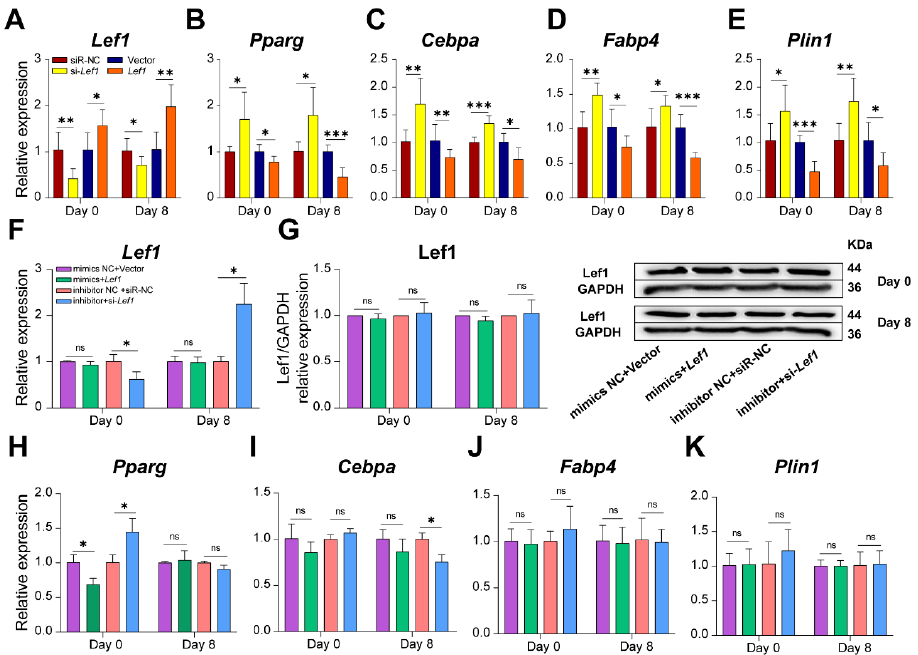
Figure 8. miR-34a abolished the suppressive function of overexpressed Lef1 on fat deposition during 3T3-L1 differentiation. The expression of Lef1 ( A ), Pparg ( B ), Cebpa ( C ), Fabp4 ( D ), and perilipin1 ( E ) after cells transfected with pcDNA3.1- Lef1 , si Lef1 and their corresponding control during cell differentiation ( n = 6). The expression of Lef1 ( F ), Pparg ( H ), Cebpa ( I ), Fabp4 ( J ), and perilipin1 ( K ) after cells transfected with miR-34a mimics NC + pcDNA3.1 or mimics + pcDNA3.1- Lef1 or with miR-34a inhibitor NC + siNC or inhibitor + si Lef1 during cell differentiation ( n = 3). The protein expression of Lef1 during cell differentiation in the rescue experiment ( n = 3) ( G ). * p < 0.05, ** p < 0.01, *** p < 0.001 versus NC.